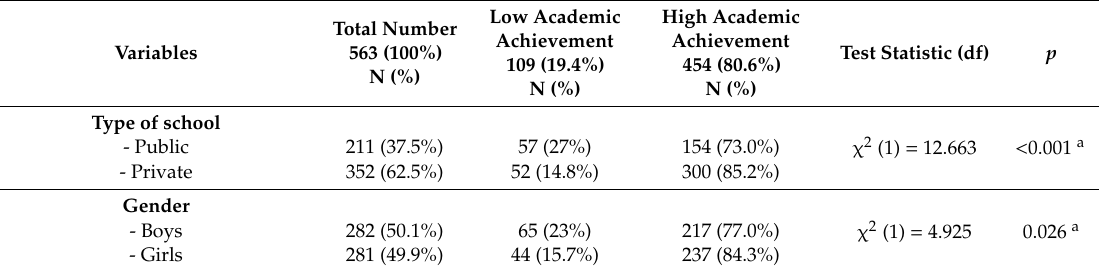
Association of Socio-demographics and Anthropometric Measurements with Academic